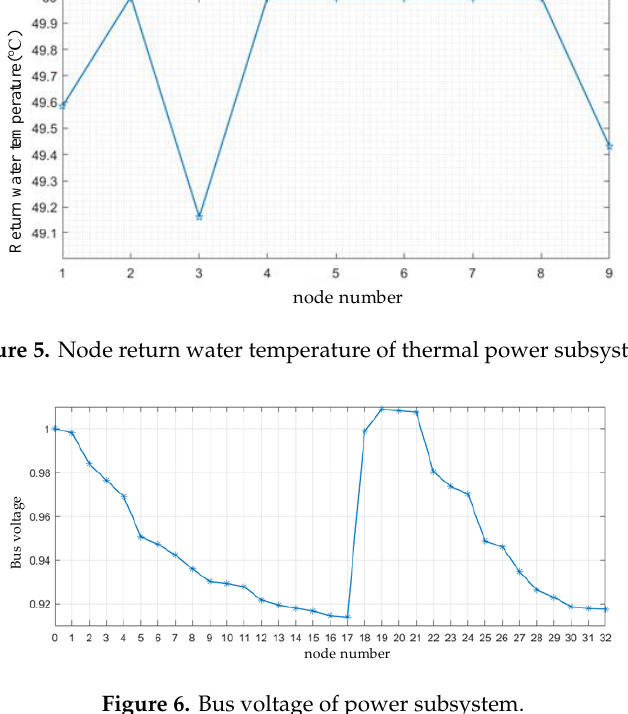
Figure 6. Bus voltage of power Figure 6. Bus voltage of power subsystem. Figure 6. Bus voltage of power subsystem. Figure 6. Bus voltage of power subsystem. Figure 6. Bus voltage of power subsystem.